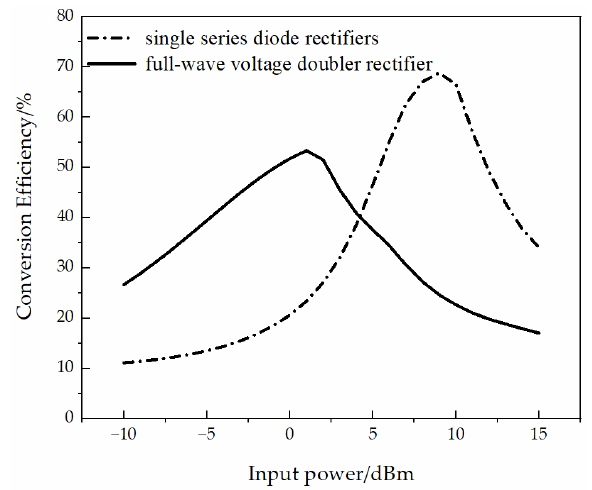
Figure 10. Conversion efficiency comparison between single series diode rectifier and full ‐ wave voltage doubler rectifier.